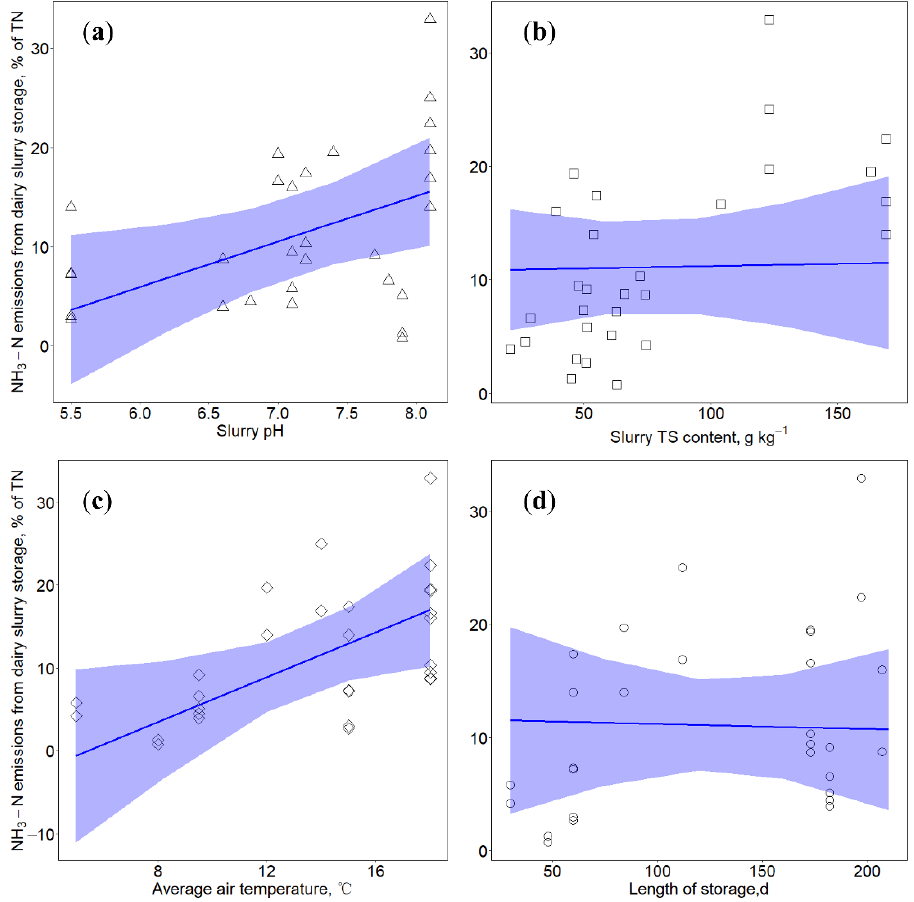
Figure 1. Relationships between NH 3 –N emissions from dairy slurry storage with ( a ) slurry pH (in triangle), ( b ) total solids (TS) content (in square), ( c ) air temperature (in diamond) and ( d ) length of storage (in circle). Blue lines indicate prediction lines based on results of linear mixed effects model: lmer (NH 3 –N ~ pH + TS + T + LOS + (1|Reference)). Blue shadows represent model predicted results with 95% confidence interval.